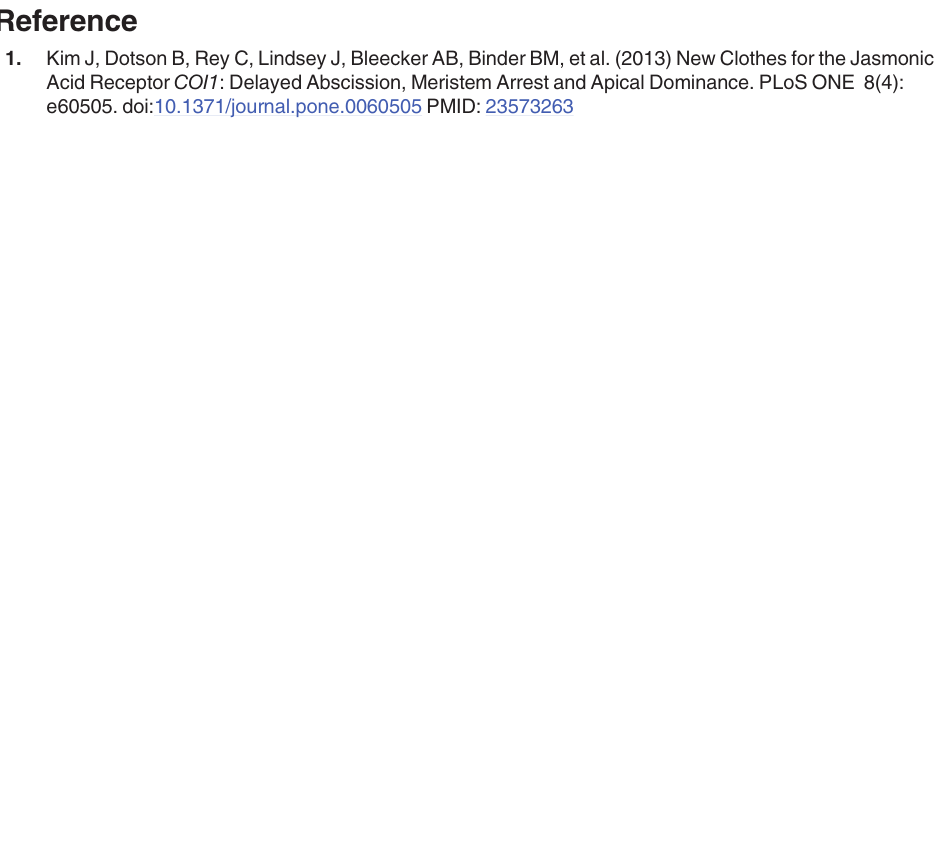
S4 Fig. Leaf senescence of JA mutants and ethylene mutant ein2 – 1 . Comparison of leaves from wild type WS and Col to coi1 – 37 , aos and ein2 – 1 . Leaves were treated with 200 μ M